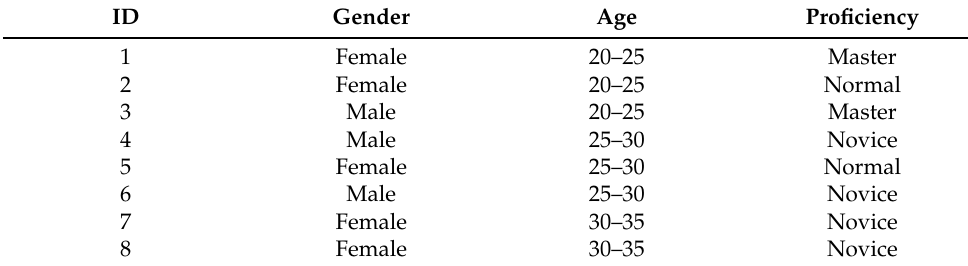
Table 1. Demographics of